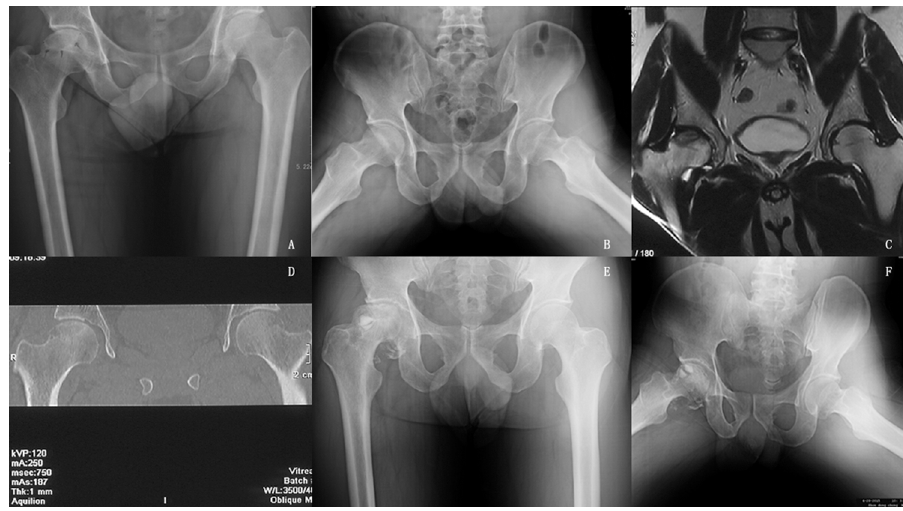
Fig 4. Kaplan – Meier survival curve shows that hips with necrotic lesions involving the lateral pillar (L2, L3 type) are more likely to fail bone grafting.